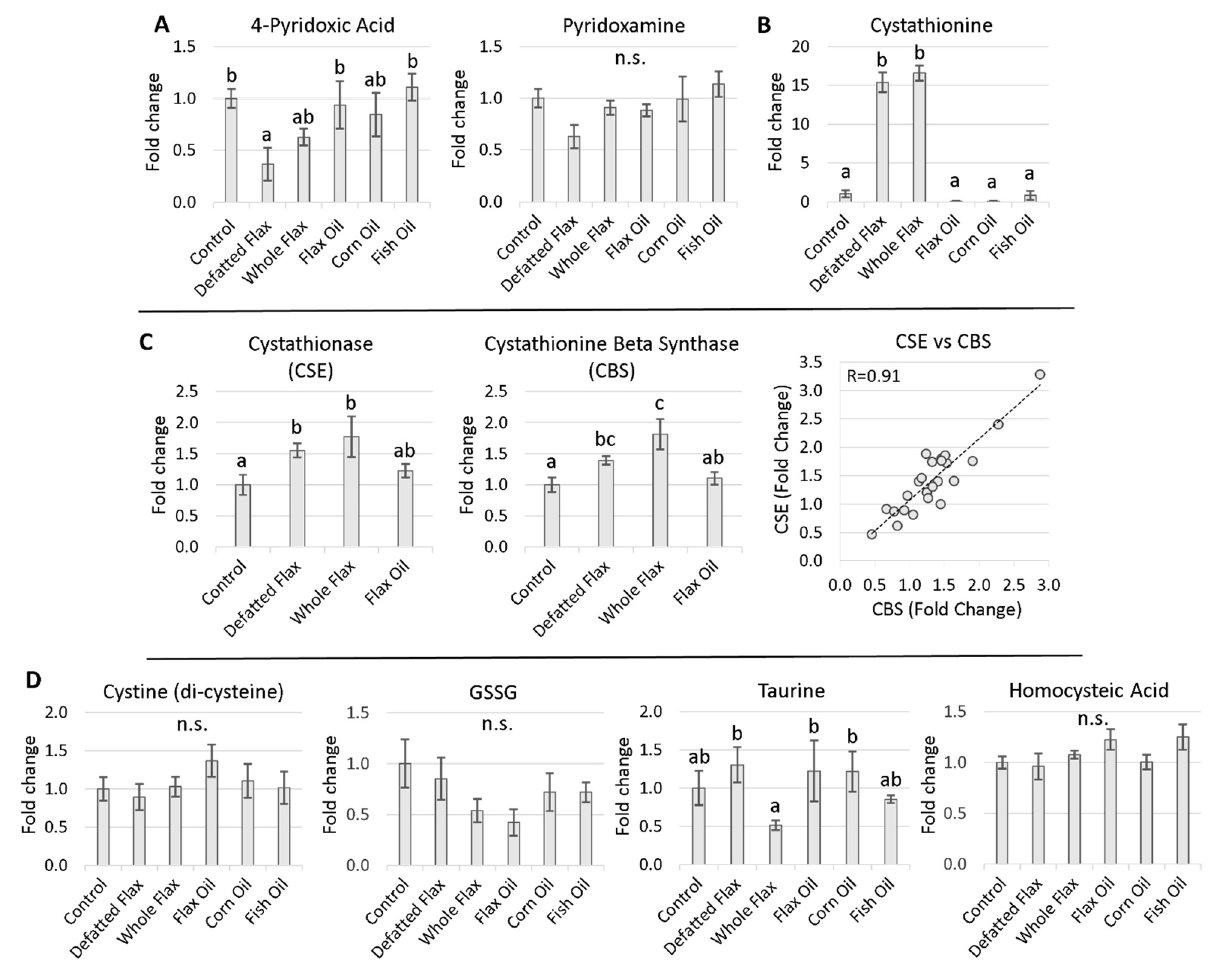
Figure 3 . Estimates of vitamin B6 metabolism, transsulfuration, and sulfur-based metabolites generated downstream of transsulfuration: Hen plasma samples were measured via LC-MS/MS. Plasma markers for B6 metabolism were measured ( A ). Plasma markers for transsulfuration flux were also measured ( B ). Gene transcripts for CBS and CSE were measured in hen liver homogenates via qPCR (using GAPDH as reference) ( C ). Thiol metabolites that were generated subsequent to transsulfuration were measured ( D ). VIP scores of plasma metabolites and fold changes of gene transcripts were analyzed via one-way ANOVA (Duncan’s post-test, p < 0.05). Groups lacking a similar letter (i.e., a,b,c) are significantly different. “n.s.” is used to illustrate a non-significant ANOVA. A sample size of 6 was used for each group in ( C ). The sample sizes for the groups in ( A , B , D ), are stated in the Materials and Methods section (Section 5.3). The F-test result for 4PA was p < 0.056. Error bars are +/ −